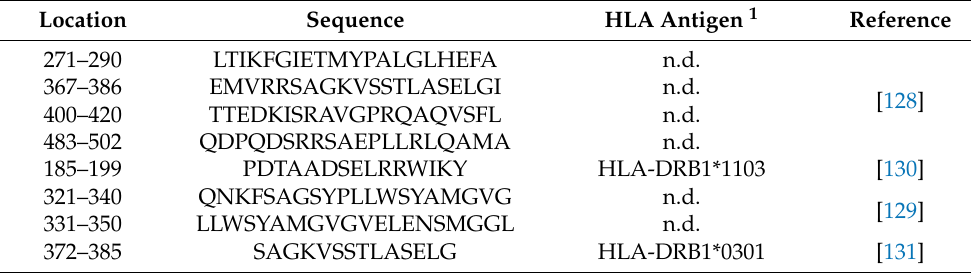
Table 1. CD4+ T-cell epitopes of the measles